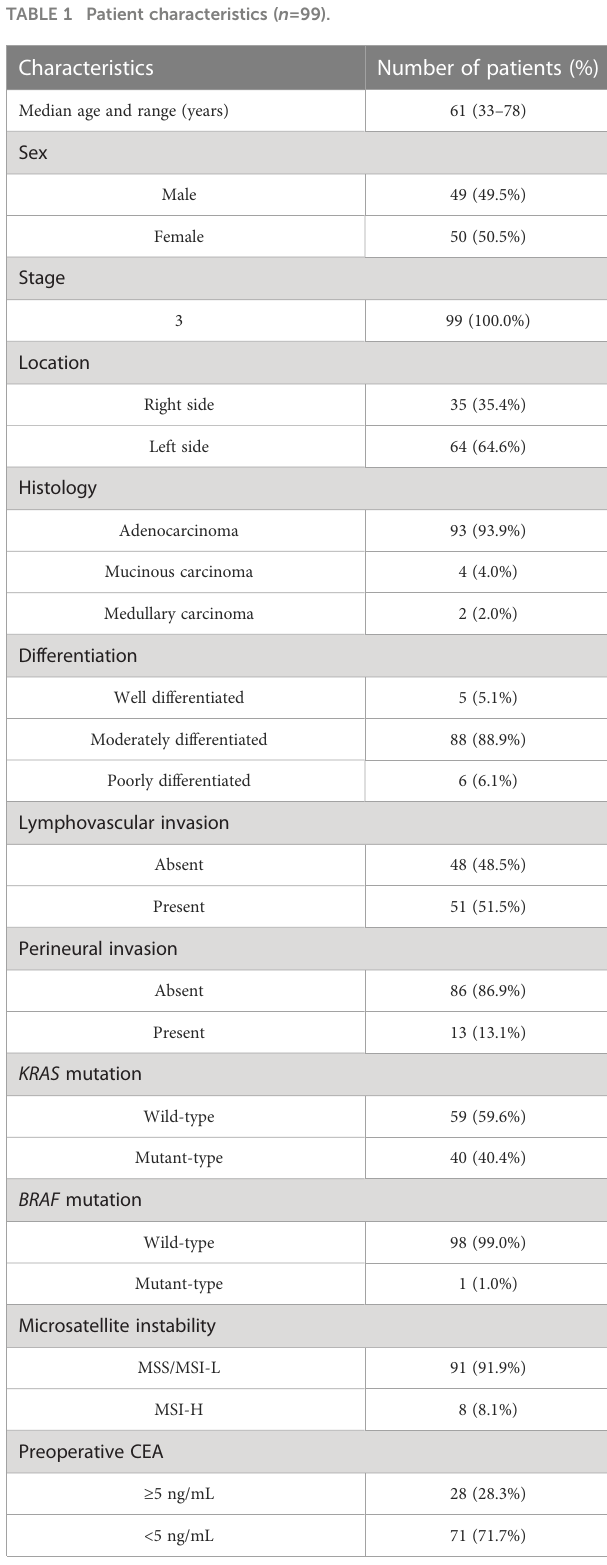
TABLE 1 Patient characteristics ( n